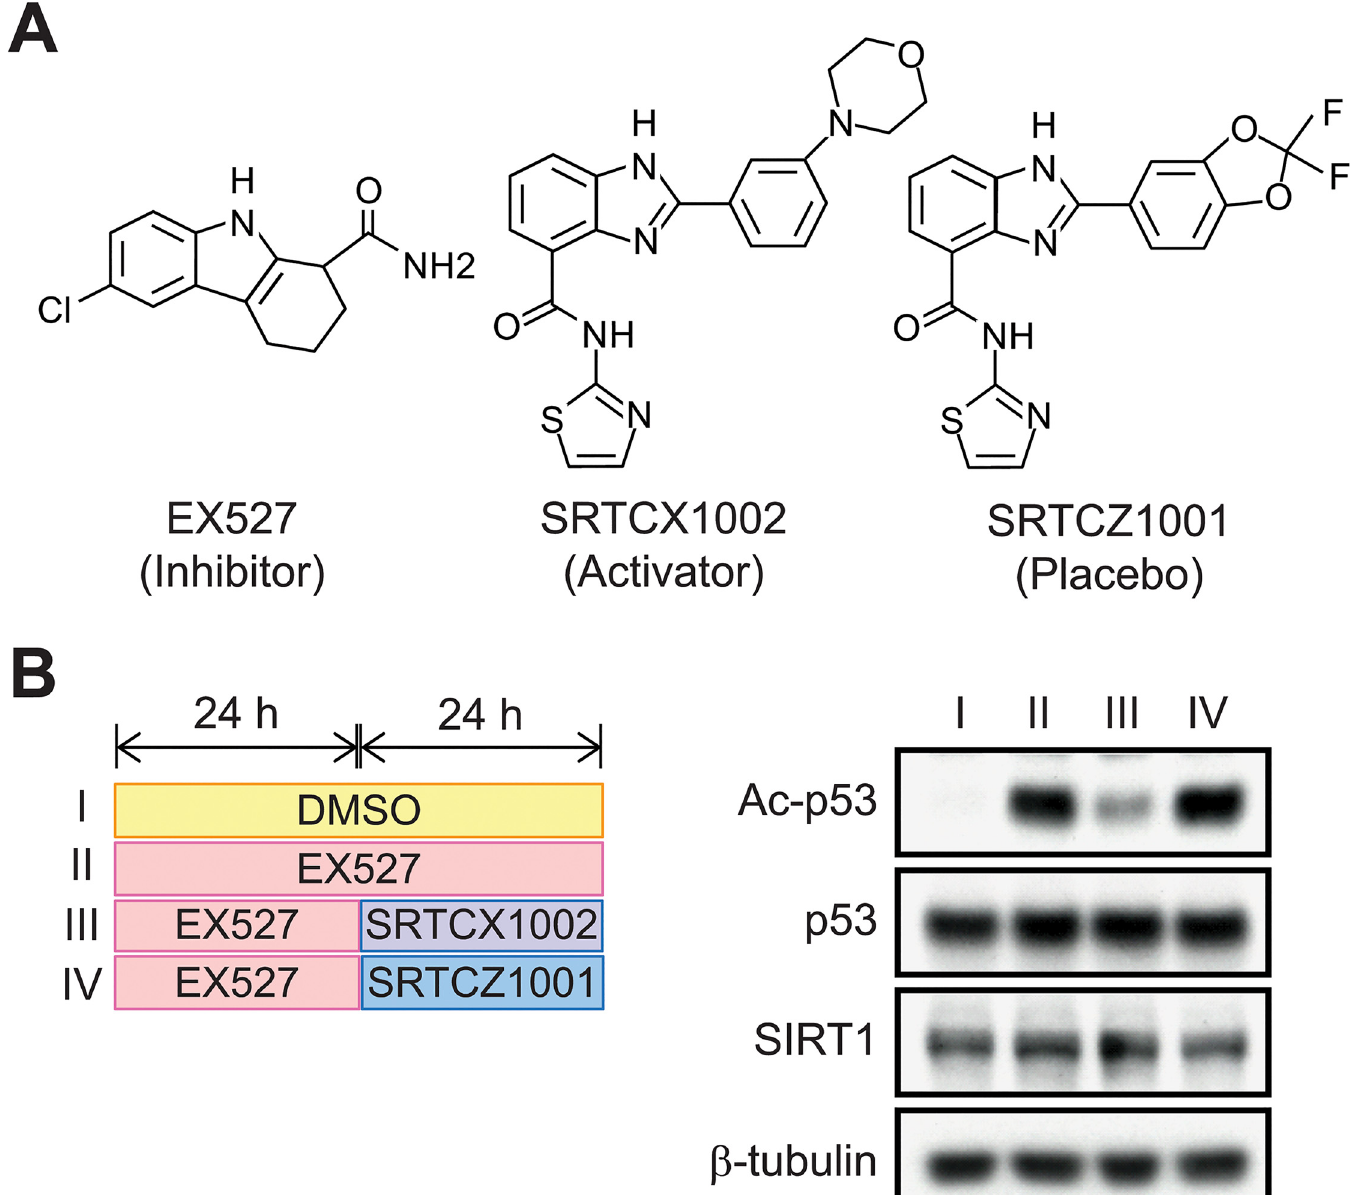
Fig 1. Validation of SIRT1 modulators in HEK293 cells. (A) Chemical structures of the SIRT1 modulators EX527 (an inhibitor), SRTCX1002 (an activator) and SRTCZ1001 (a placebo). (B) HEK293 cells were treated with DMSO (blank control, I) or EX527 (II) for 48 hours or EX527 for 24 hours and then switched to SRTCX1002 (III) or SRTCZ1001 (IV) treatment for an additional 24 hours (left panel). The acetylation levels of p53 lysine-382, a known target of SIRT1 deacetylation, were examined by western blotting using a specific antibody. The p53 and SIRT1 protein levels were also determined by western blotting. β - tubulin was used as a loading